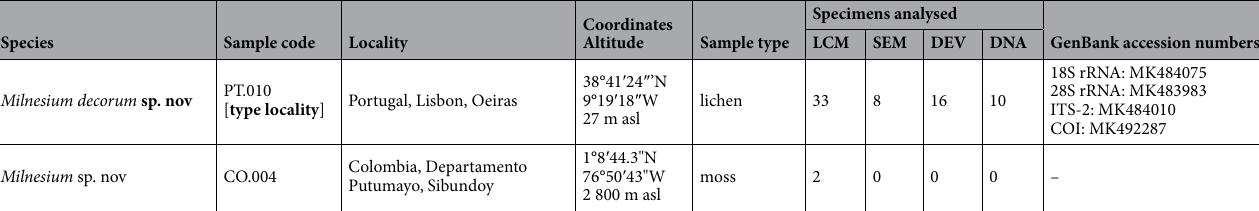
Table 1. The collection details of populations analysed in this study. Analysis types: LCM—morphometry and imaging in PCM and UVM; DNA—DNA sequencing; SEM—imaging in SEM; DEV—developmental analysis (ontogenetic